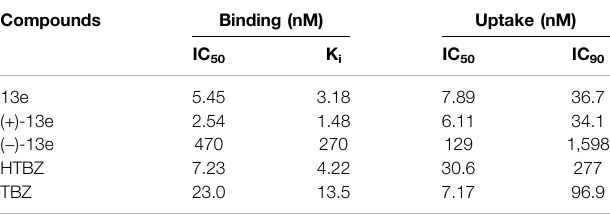
TABLE 2 | In vitro vesicular monoamine transporter 2 (VMAT2) binding af fi nity in the rat brain and inhibition of [ 3 H]DA uptake in rat striatal synaptosomes.